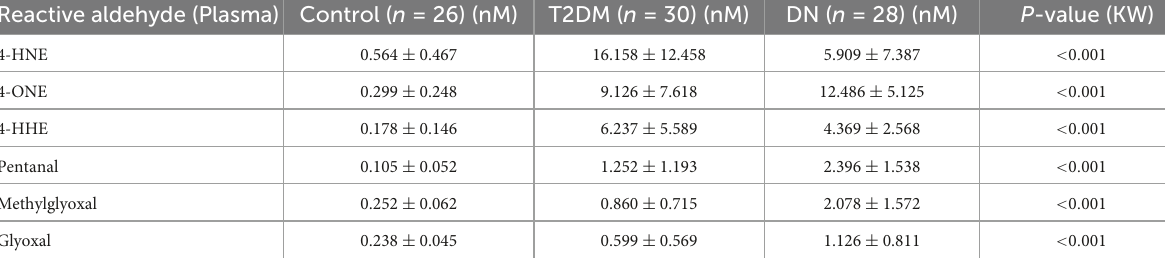
TABLE 5 Reactive aldehydes in plasma (mean ±